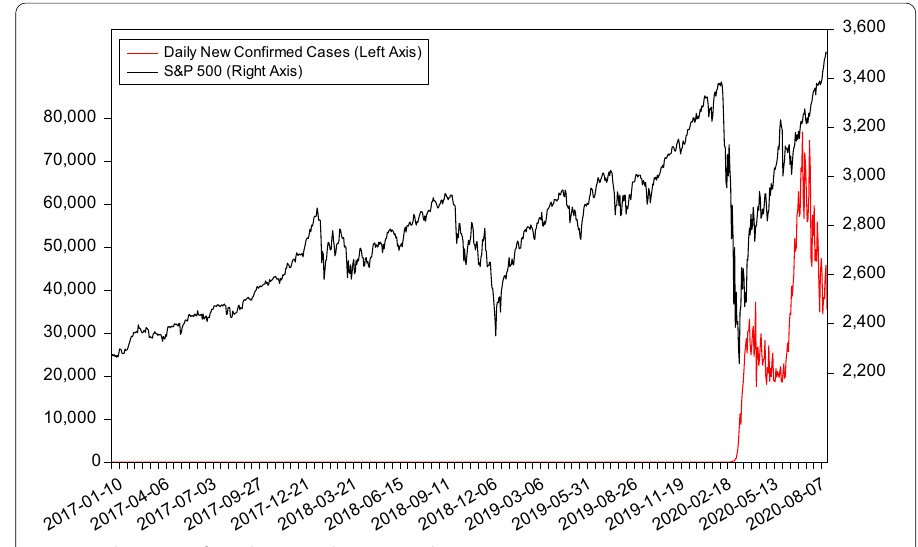
Fig. 1 Daily new confirmed cases and S&P 500